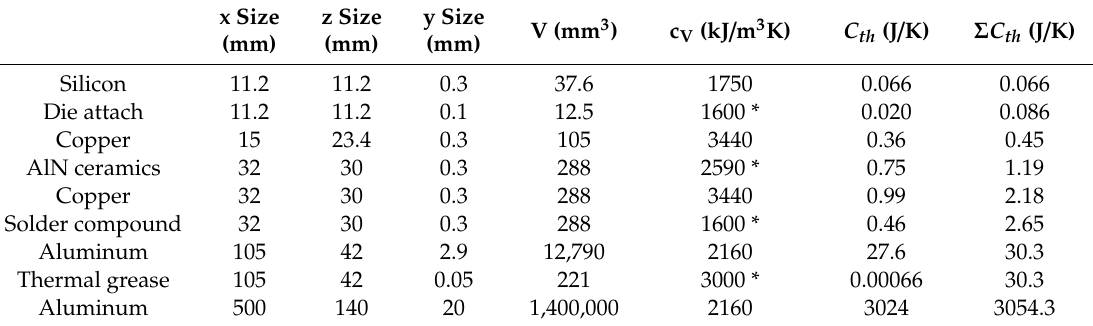
Symbol * denotes estimated values based on